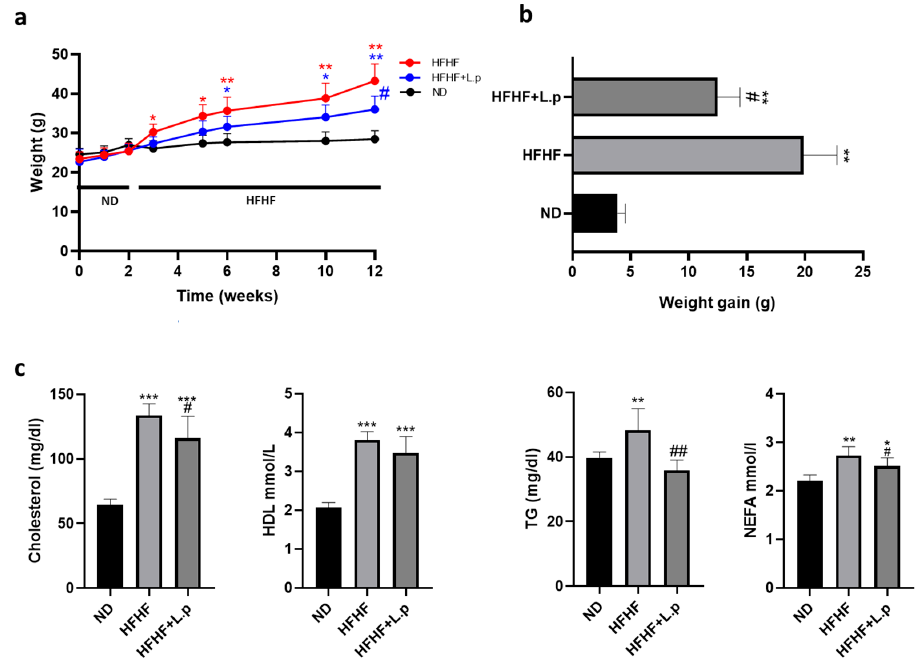
Figure 1. Body weight, weight gain, and serum lipid profile in HFHF mice. ( a ) Changes of body weight during the animal experimental study. ( b ) Differences of body weight gain between groups. ( c ) Levels of total cholesterol, HDL, triglycerides (TG), and non-esterified fatty acids (NEFA). Data are expressed as mean ± SEM. * p < 0.05, ** p < 0.01, *** p < 0.001 vs. ND group: # p < 0.05, ## p < 0.01 vs. HFHF